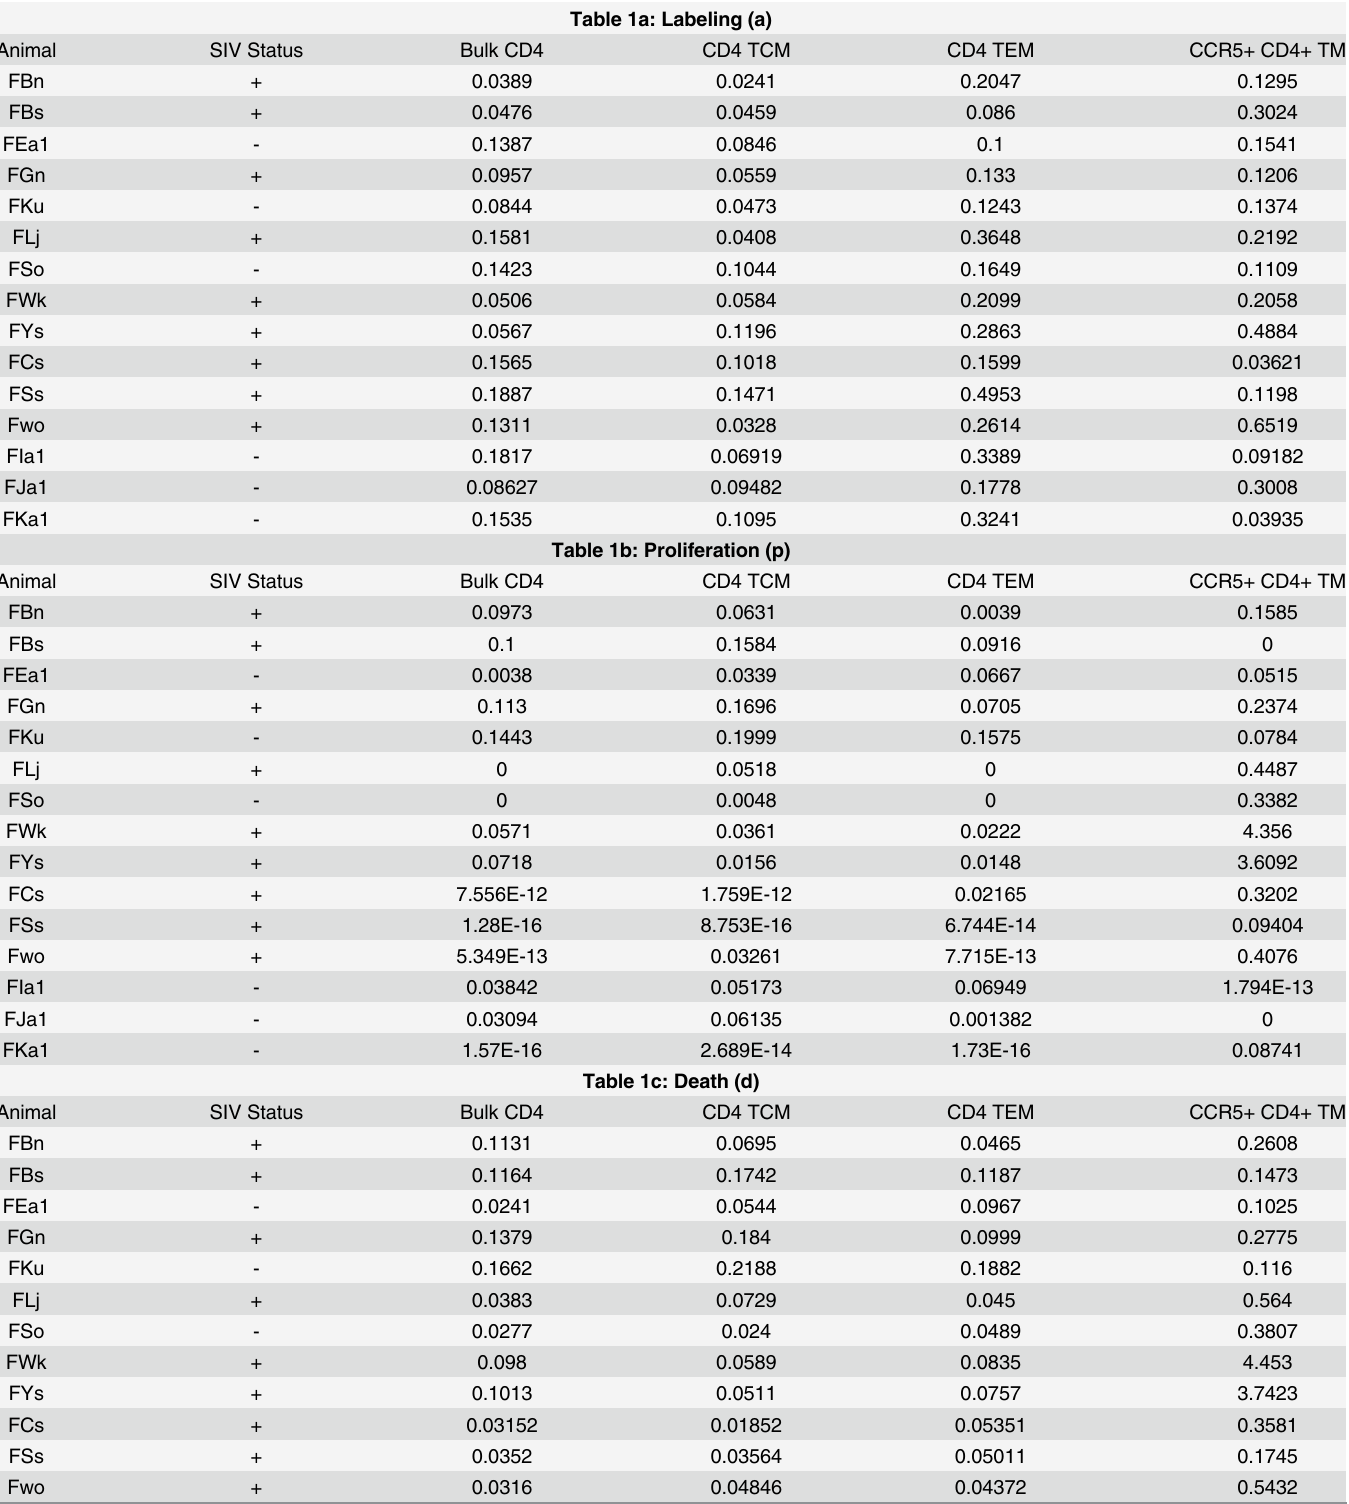
Table 1. a, p, and d values for CD4+ T-cell subsets.